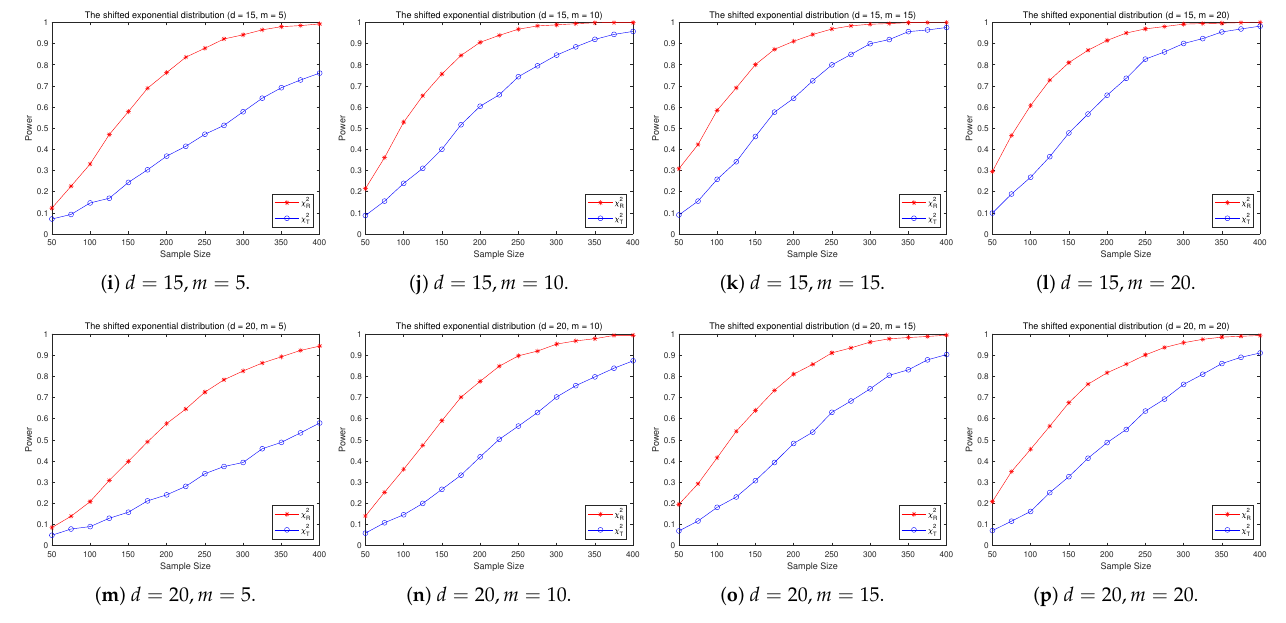
Figure 5. The shifted exponential distribution exp ( 1 ) . Red line for RP-chi-square, blue line for traditional chi-square.